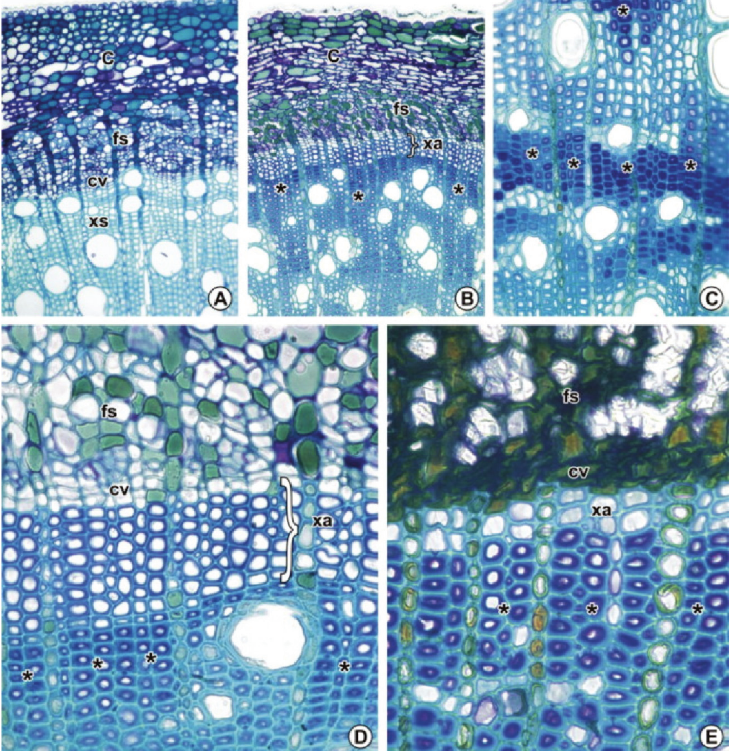
Figure 3. Cross-sections of young portions of the healthy stem of clone 386 (a) and with lesions from ESBVRD (b-e). (a) general appearance of the bark and of the wood of the healthy stem; (b) general appearance of the bark and of the wood with anomalous xylem fascicle; (c) detail of the wood with irregular lignification pattern; (d) detail of the previous figure; and (e) stage when the entire cambium region and the secondary phloem are completely phenolized and collapsed.